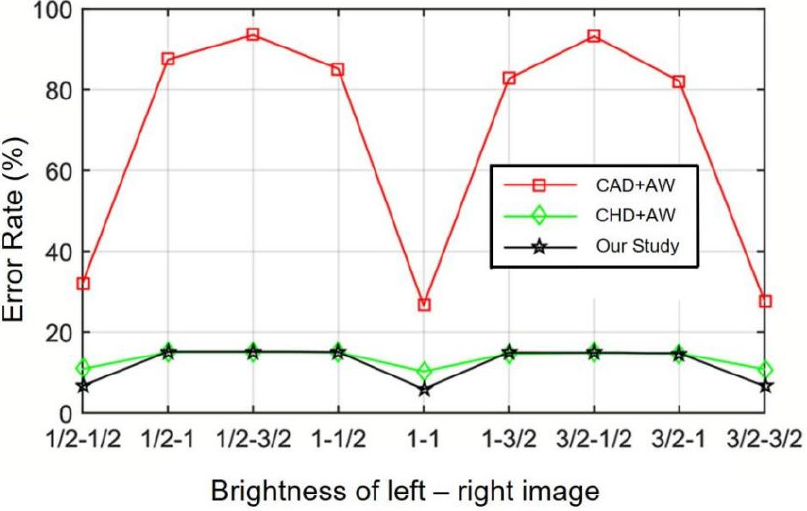
Table 5. Matching error rate of parallax images before and after post-processing.